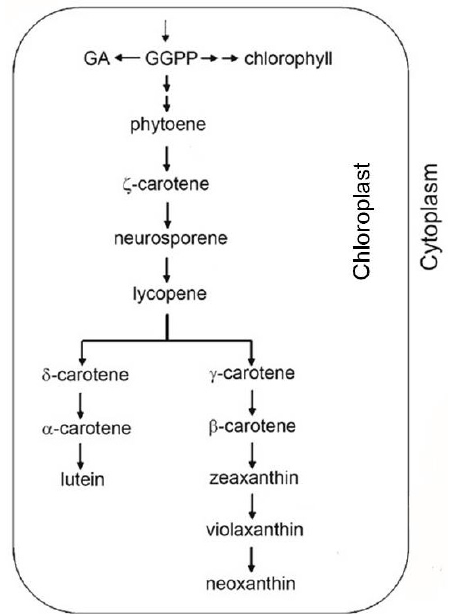
Figure 5. Carotenoids are the accessory pigments ubiquitous in photoautotrophs. These pigments participate in light-harvesting, fulfill photoprotective functions, and stabilize the pigment-protein complexes of the photosynthetic